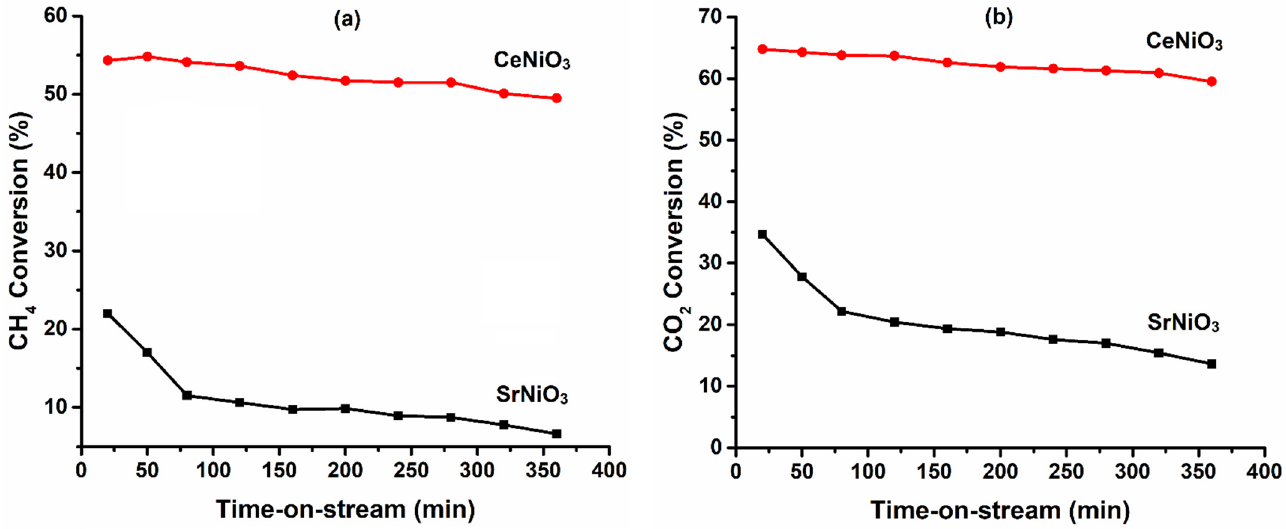
Figure 5. ( a ) CH 4 conversion, and ( b ) CO 2 conversion versus time-on-stream (TOS) of SrNiO 3 and CeNiO 3 perovskites.